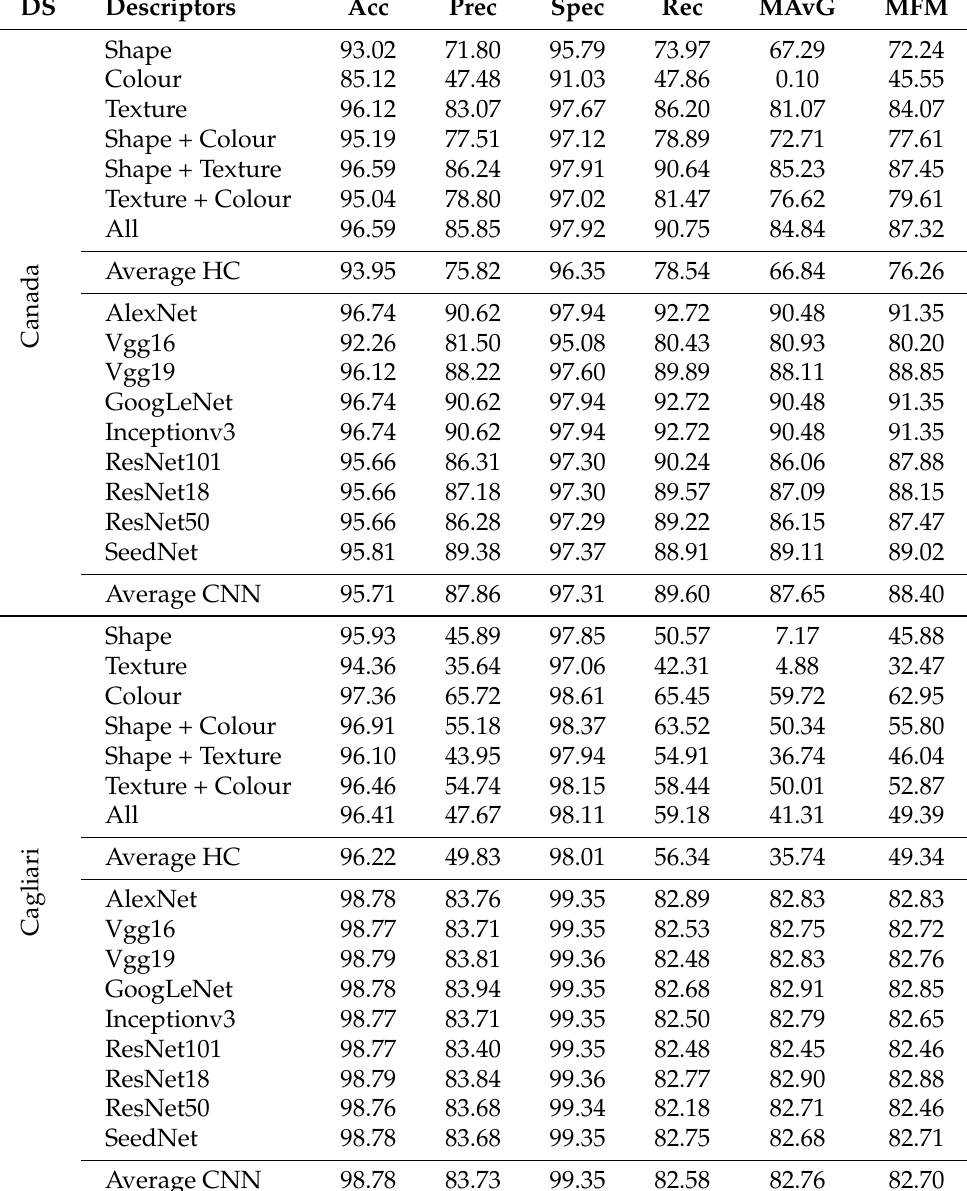
Table A3. Performance results attained using HC descriptors and deep features by Naive Bayes classifier on Canada and Cagliari data sets. Naive Bayes were trained with kernel as distribution and normal as kernel type. DS indicates the data